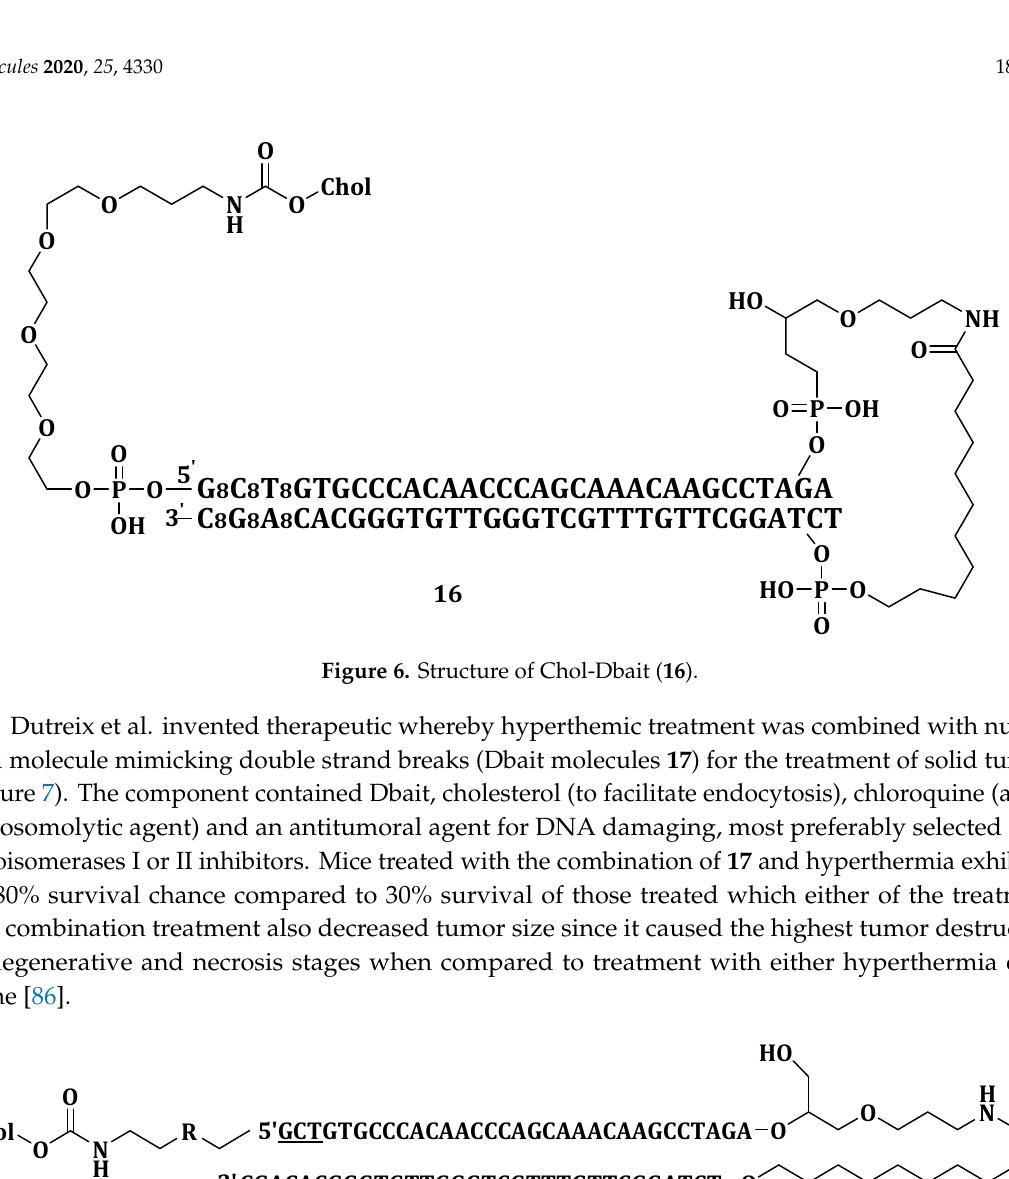
Figure 7. Structure of Chol-conjugated Dbait molecule ( 17 ).